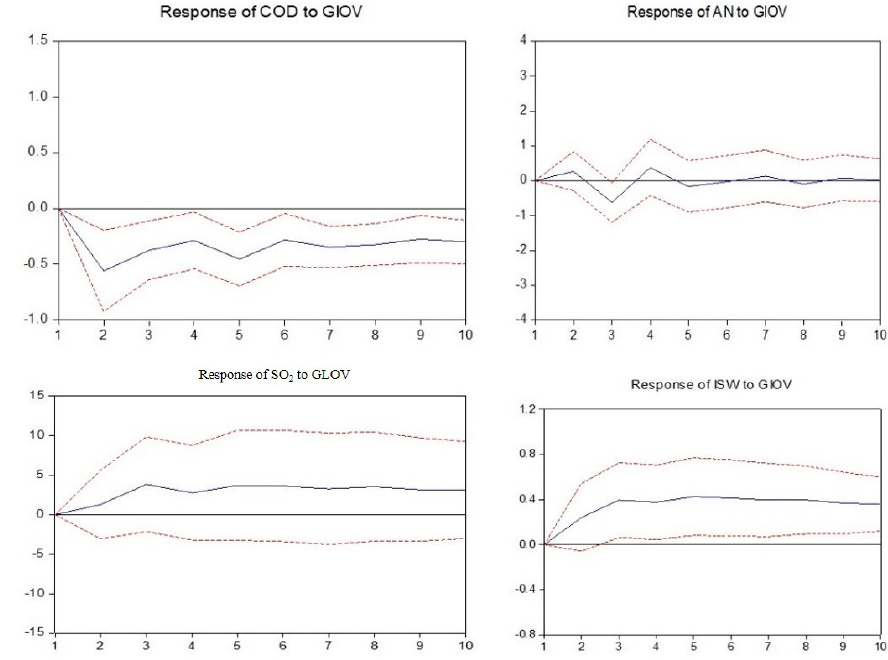
Figure 12. Responses of pollutants charged to industrial output value of mining and processing of nonmetal ores. The solid lines indicate the mean responses to a one standard deviation shock, while the dotted lines represent ± 2 standard deviations of the responses.